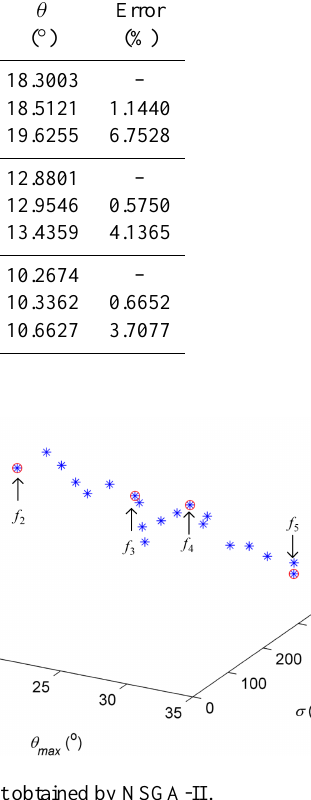
Figure 9. Pareto front obtained by